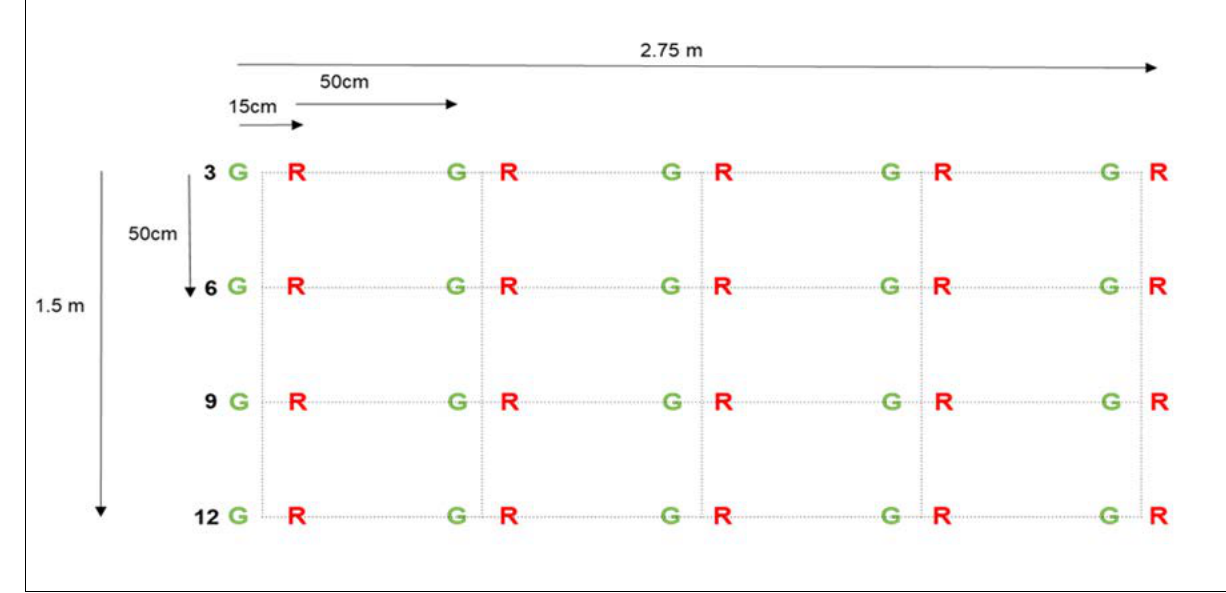
Figure 1: Experimental plot layout consisting of a paired tea bag design across four incubation